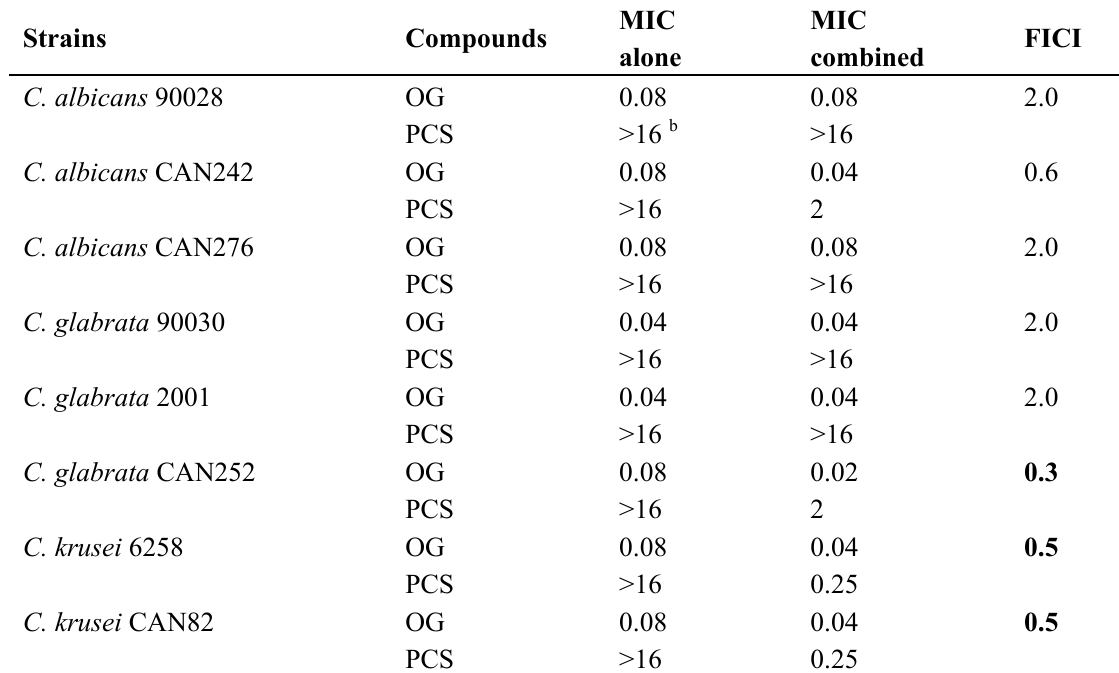
Table 8. Antifungal chemosensitization of OG (mM) to PCS ( μ g/mL) tested against Candida strains: EUCAST-based microdilution bioassays.